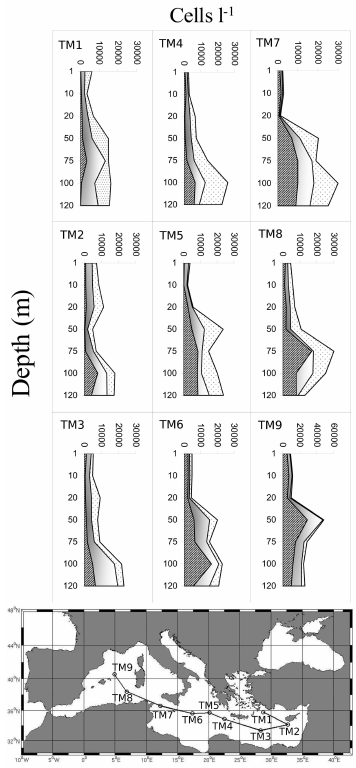
Fig. 11. Vertical profiles of diatoms (dotted), dinoflagellates (light gray) and coccolitophores (dark hatched gray) over an east-west longitudinal transect of the Mediterranean Sea in June 1999. Modified with permission from Ignatiades et al. (2009).